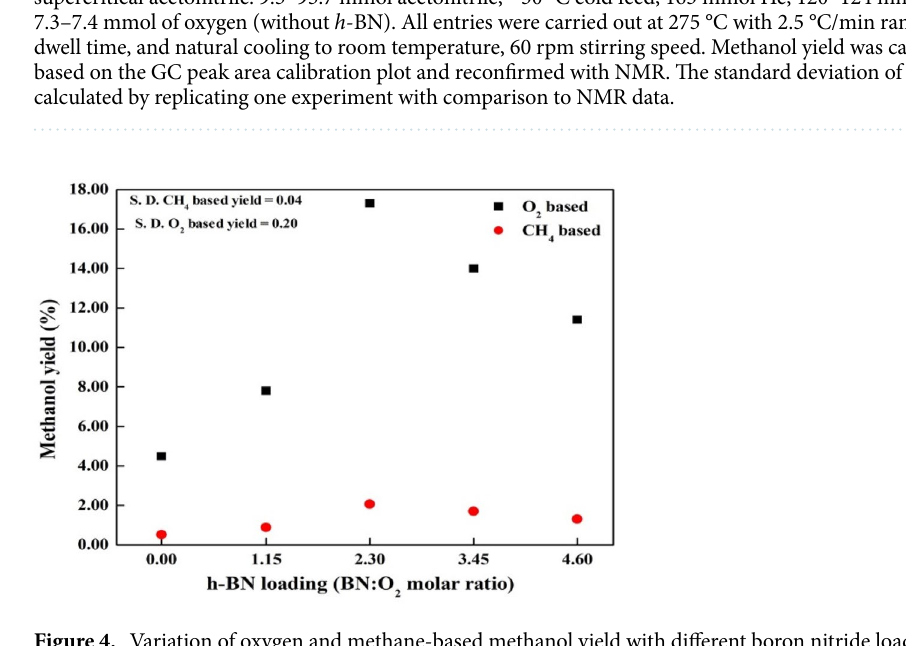
Figure 4. Variation of oxygen and methane-based methanol yield with different boron nitride loading. All runs were conducted with the specified amount of h -BN, 118 mmol of CH 4 , 7 mmol of O 2 , 163 mmol of He, 57